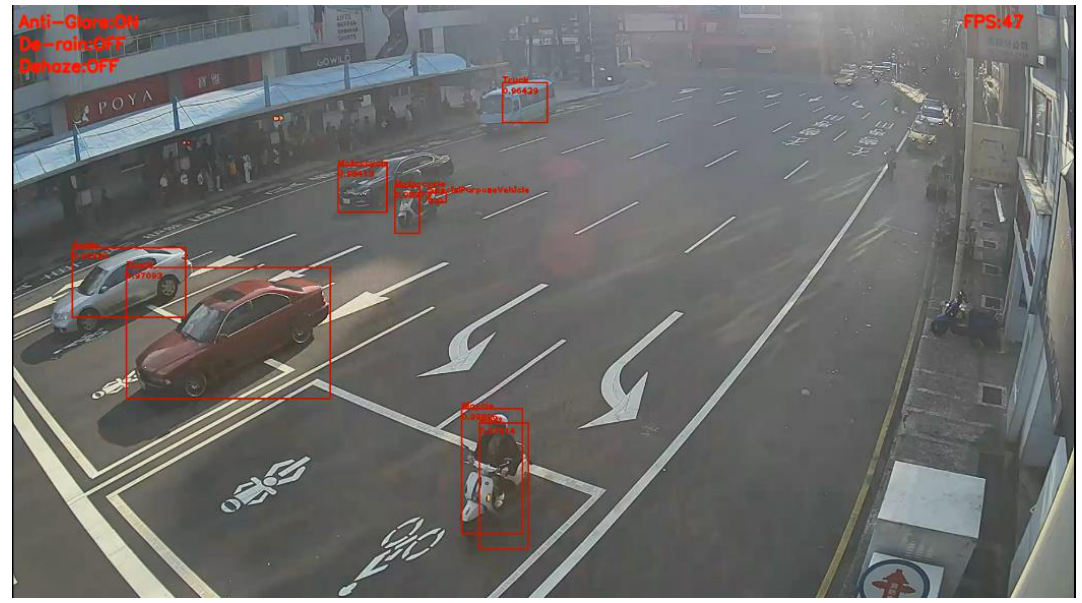
Figure 24. Low-contrast scene image frame detected by our proposed system.